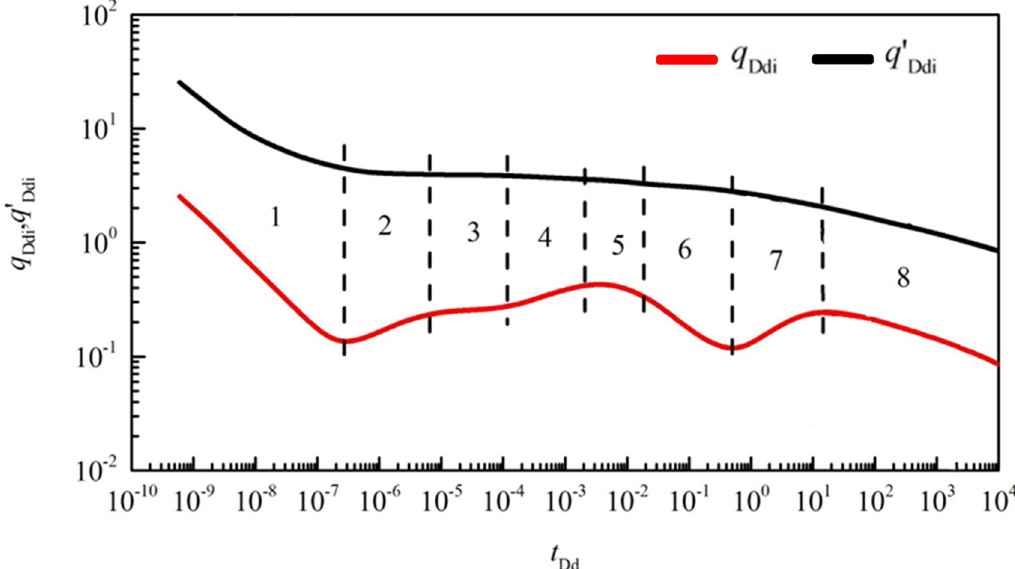
Figure 3. Production decline characteristic curve of gas-water two-phase multi-stage fractured hor- izontal wells in the shale gas reservoir. horizontal wells in the shale gas